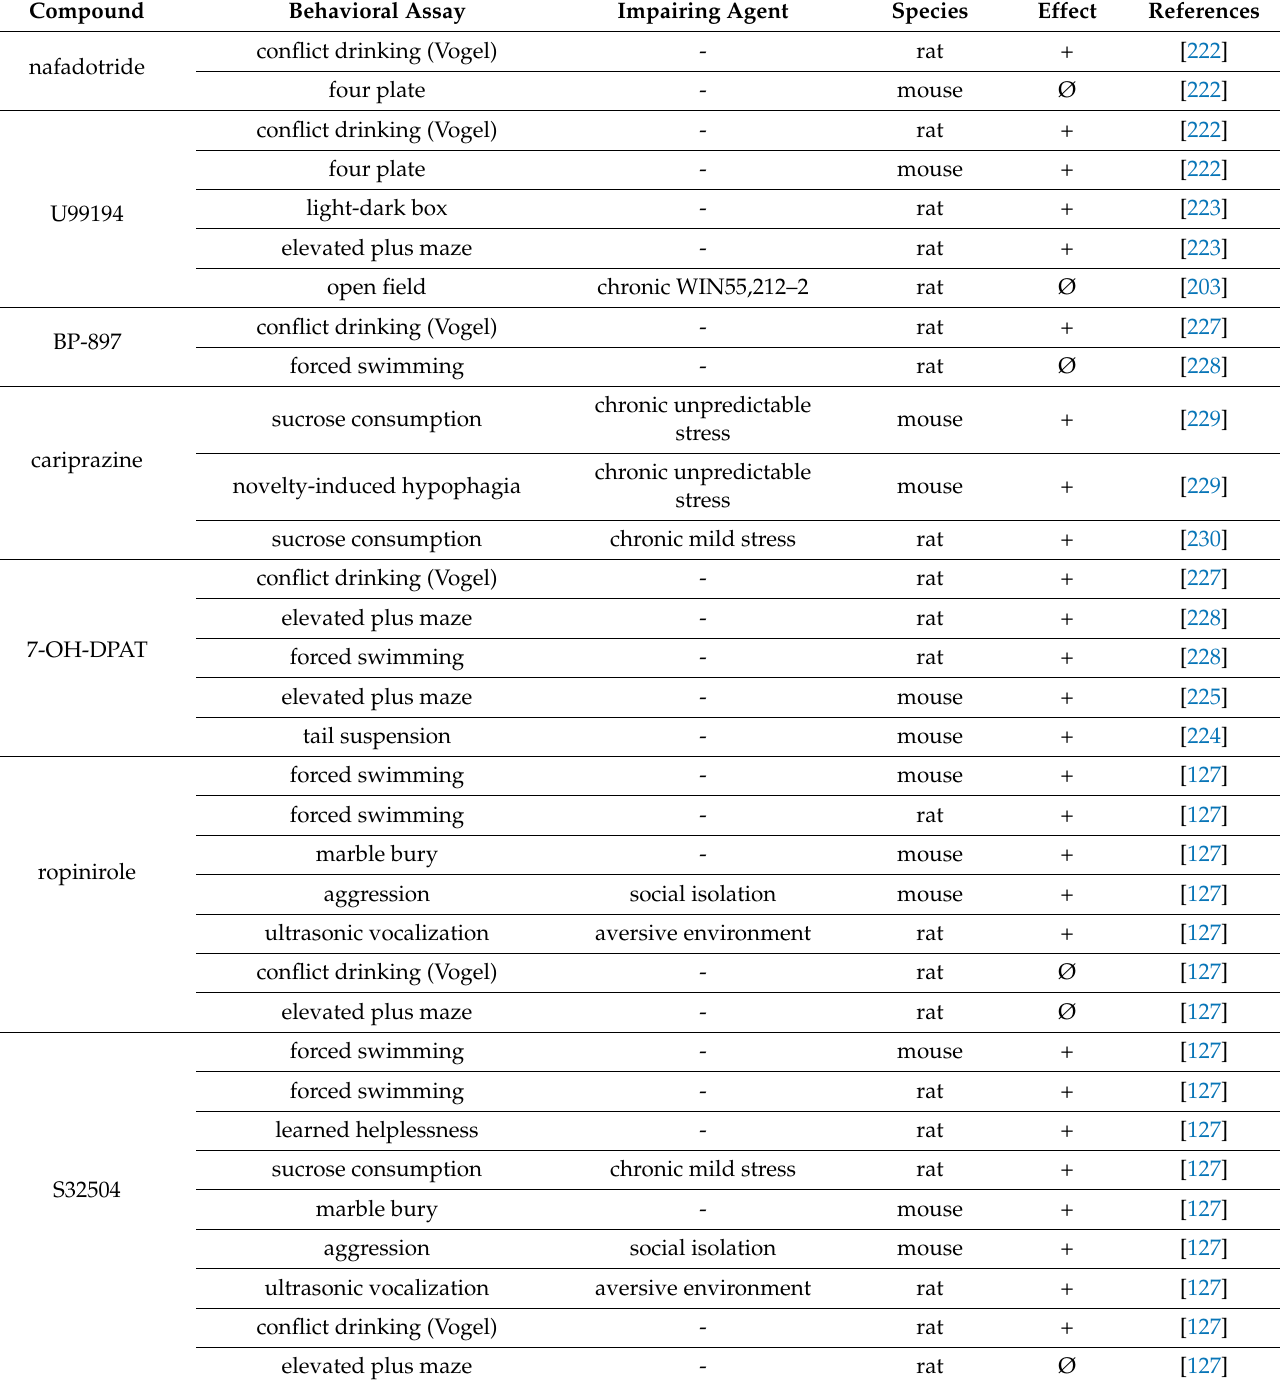
Table 5. Behavioral effects of D3R ligands on anxiety, anhedonia and stress reactivity.